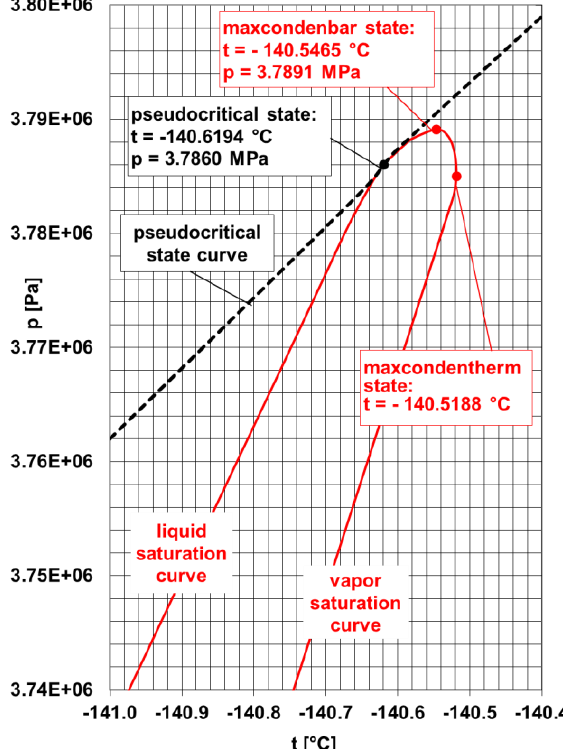
Fig. 5. Liquid and vapor saturation curves in the phase p t  diagram for the dry Fig. 4. Liquid and vapor saturation curves in p-v diagram for dry air components: nitrogen N - green, oxygen O - blue. 2 2 Table 5 . Parameters of the pseudocritical point of air [2].